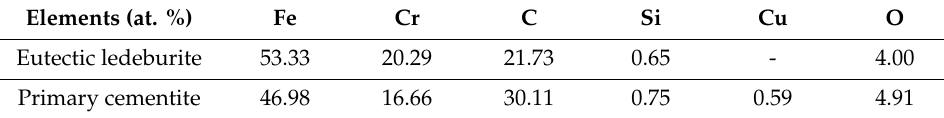
Figure 3. Microstructure of 2Cr13 coating: ( a ) observed by OM, ( b ) observed by SEM. Table 2. Chemical compositions of different phases in coatings.